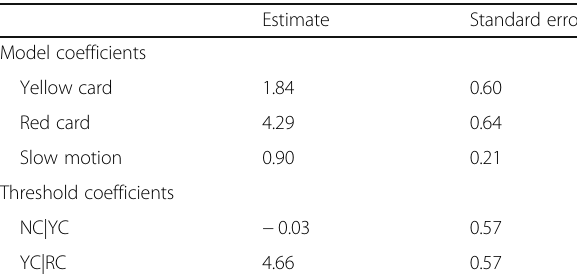
Table 2 Parameter estimates for the main effects